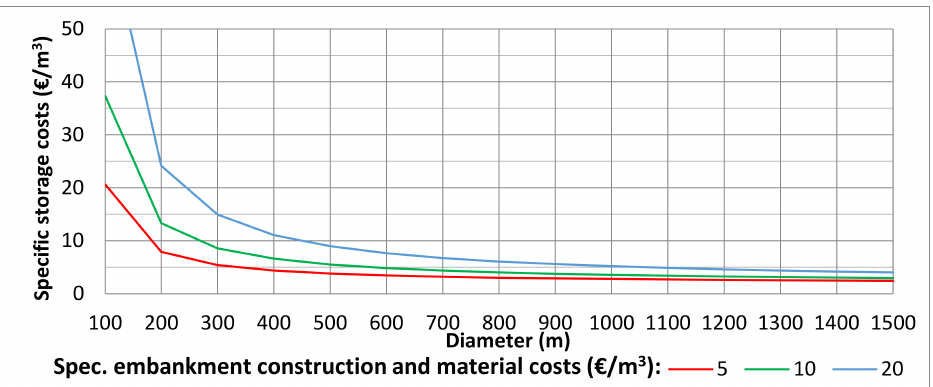
Figure 4. Costs in € per m 3 for the upper reservoir, by reservoir